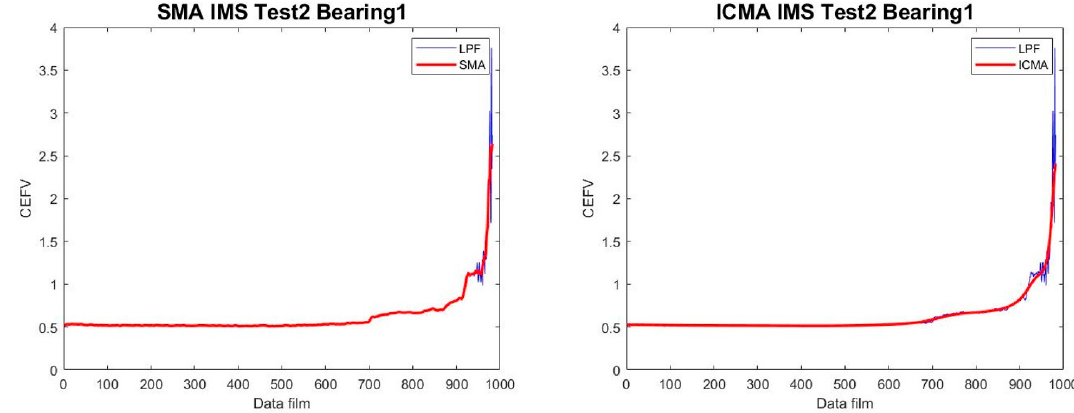
Figure 5. Comparison of the SMA and ICMA results.